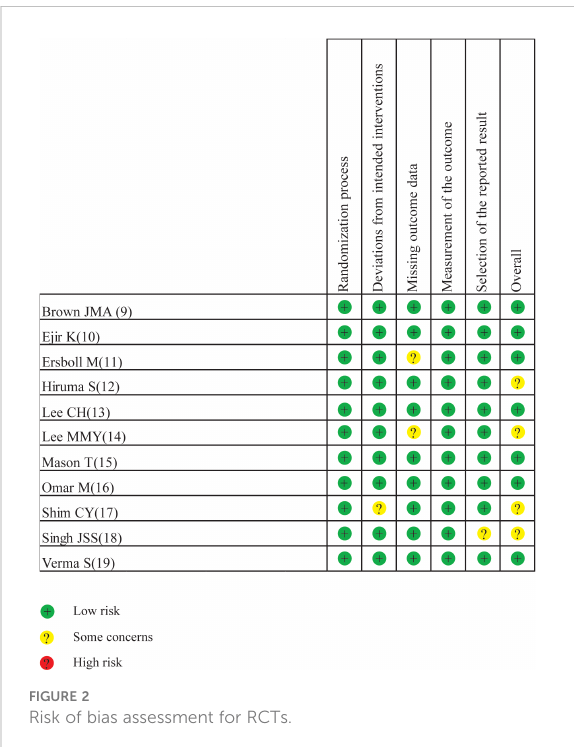
FIGURE 2 Risk of bias assessment for